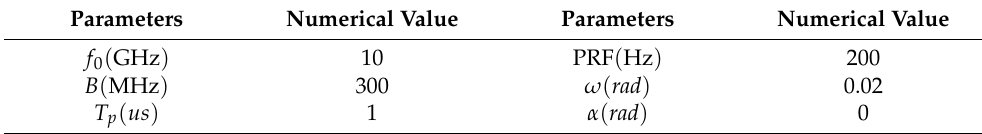
Table 1. Simulation